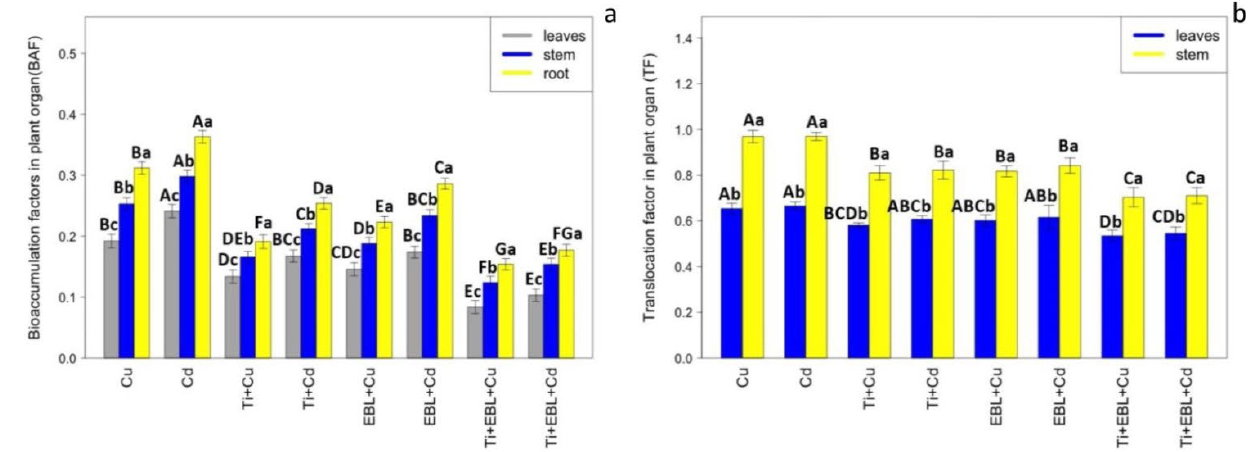
Figure 6. The impact of the co-application of 24-epibrassinolide and titanium oxide nanoparticles on BAF and TF: ( a ) the comparison between bioaccumulation of heavy metals in the root, stem, and leaves; ( b ) the comparison between translocation factor in the stem and the leaves. Bioaccumulation factor (BAF) is obtained by the difference between the concentrations of heavy metals in the leaf, stem, or root and concentrations of heavy metals in the medium, while the translocation factor (TF) is obtained by the difference between the concentration of heavy metals (Cu, Cd) in the leaves or stem of plants and the concentration of the heavy metals (Cu, Cd) in the roots of plants. The capital letters ( A–G ) indicate significant differences between treatments of control (C), titanium (Ti), 24-epibrassinolide (EBL), and 24-epibrassinolide involving individual or combined application of titanium oxide nanoparticles (EBL–TiO 2 NPs) under 100 µM Cu and 100 µM Cd (the bars with similar colors), while the lowercase letters ( a–c ) denote statistically significant differences between leaves, stem, and root at each treatment (the bars with various colors) based on Tukey′s test ( p < 0.05). Titanium is a useful element that can aid plant growth by increasing plant photosyn- thesis and enzymatic activity as well as increasing plant uptake of other nutrients [72]. One study reported that TiO 2 can enhance the absorption rate of micro-and macronutri- ents, which could be the main factor in plant growth and biomass [83]. In our study, the role of TiO 2 in increasing the plant biomass was related to an increase in nutrient absorb- ance by the plants and reduced toxicity in response to an increase in antioxidant activity. Many studies have reported that EBL increases plant growth under heavy metal stress [21,84,85]. The reduction in plant growth by heavy metal toxicity is related to the number of intercellular metal ions bound to the surface of the cell [86,87]. Our results showed that EBL could increase the plant biomass and plant growth under heavy metal toxicity, which could be related to the role of EBL in the reduction in intercellular metal ions, a phenom- enon that has been confirmed in a study on A. obliquus [63]. However, the role of EBL in plant growth regulation during the stimulation of plant defense mechanisms can also be considered. Therefore, we hypothesized that EBL increased the plant growth under heavy metal stress by promoting antioxidant capacity. The increase in Chl as well as carotenoid contents in response to EBL has been confirmed in many studies [88–91]. Conversely, EBL has the ability to control cell division and elongation by regulating xyloglucan endo- transglucosylase [92,93], thus demonstrating the positive role of EBL on plant growth and development, especially under stressful conditions. In the present research, the role of the co-application of TiO 2 NPs and EBL in improving plant biomass and plant growth seemed to be related to the ameliorative mechanisms activated by the levels of both TiO 2 NPs and EBL. The application of small-sized nanoparticles in the range of 1– 100 nm is a new strat- egy to maintain plant growth and development under heavy metals and other abiotic stresses. However, the build-up of TiO 2 NPs within the plant organs can have dual effects of growth promotion and suppression. Titanium dioxide nanoparticles (TiO 2 NPs) lead to several beneficial outcomes on the physiological, morphological, and biochemical traits of some plant species, which has been indicated in some studies [94,95] as well as our present